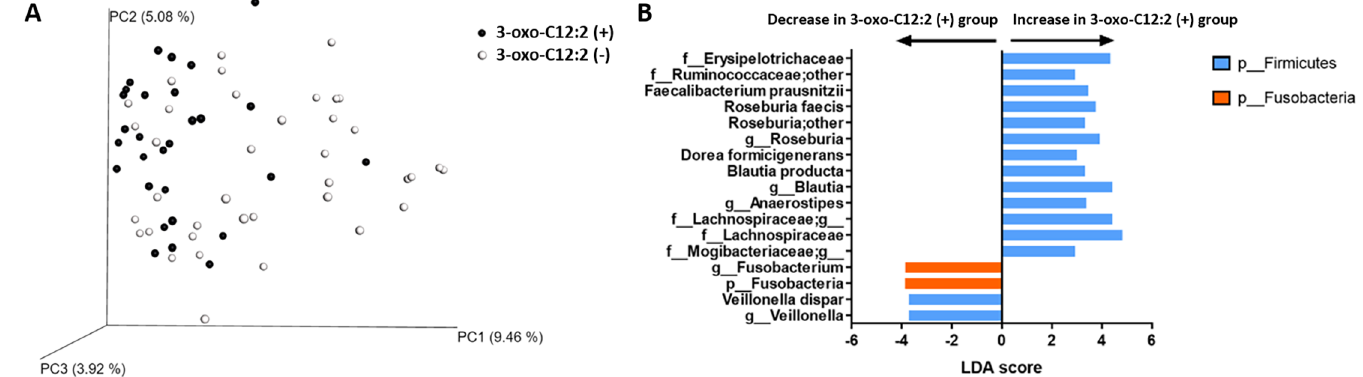
Fig 6. Bacterial composition among faecal samples according to AHL 3-oxo-C12:2 detection (3-oxo-C12:2 [+] group) or AHL 3-oxo-C12:2 absence (3-oxo-C12:2 [–] group). A: Beta diversity according to Bray Curtis index between the two groups. B: Bacterial taxa that were differentially represented in the 3-oxo-C12:2 (+) group with statistical levels of significance according to linear discriminant analysis (LDA score > 2). Taxa were identified at the order, family, gender or species level and colour-coded according to their phylum.